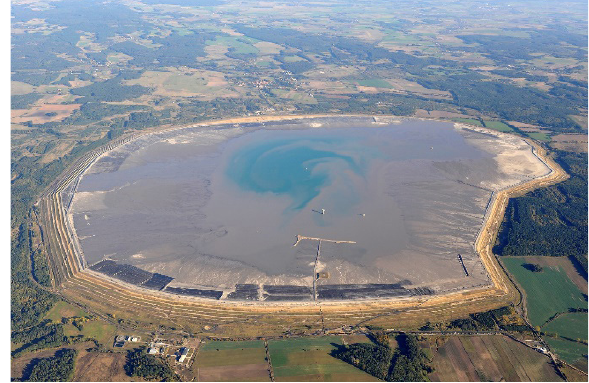
Figure 1: TSF Żelazny Most.